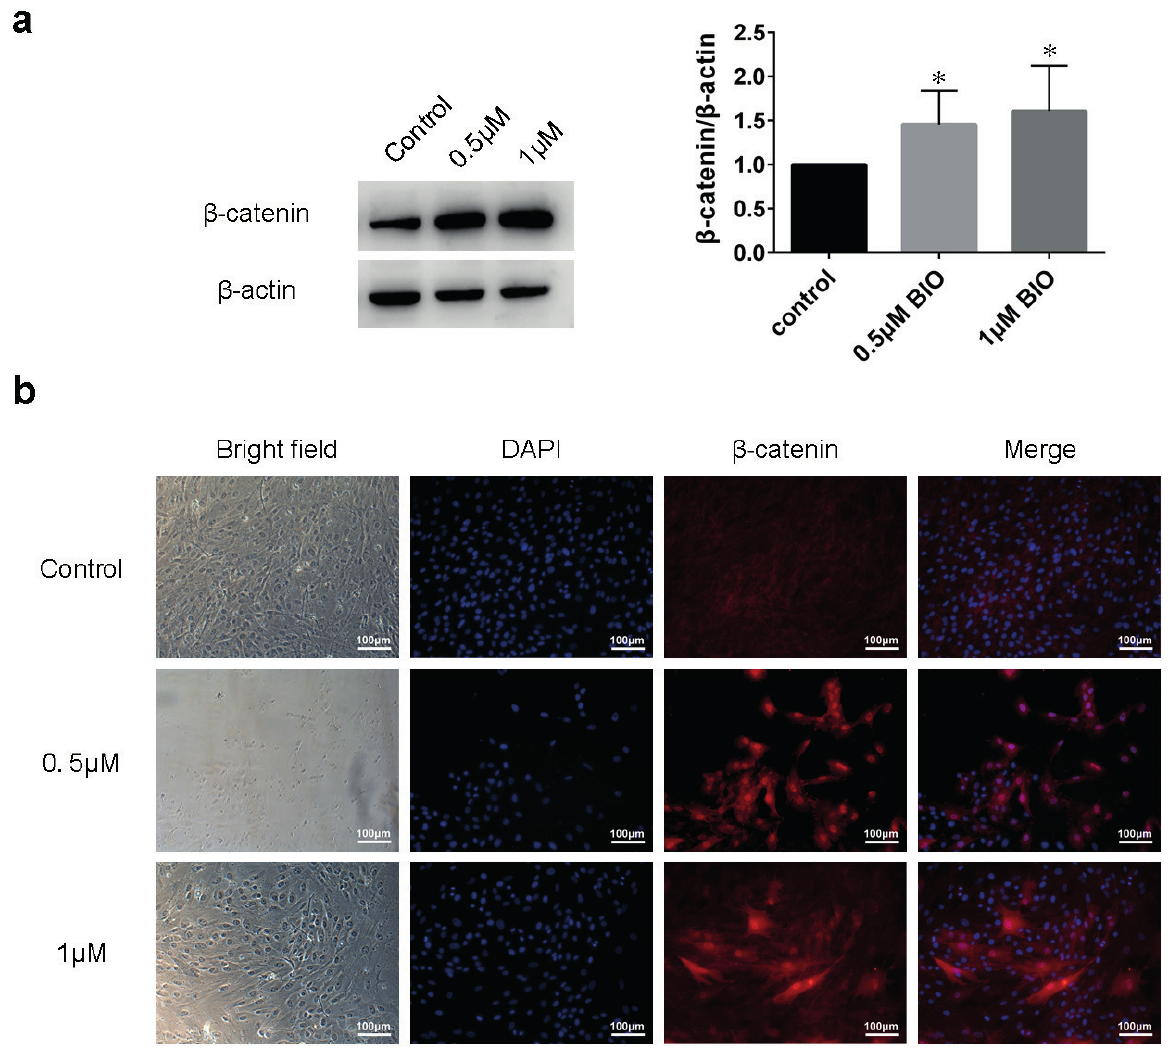
Figure 4 - BIO activated Wnt/β-catenin signalling pathways in canine BMSCs. ( a ) BIO up-regulated β-catenin expression in canine BMSCs. ( b ) BIO promoted the accumulation of β-catenin in the cell nuclei. Canine BMSCs were incubated with basic medium, osteogenic medium with or without BIO for 4 days, detected expression of β-catenin by Western blot and immunocytochemistry staining. (n = 3). Error bars denote mean ± SD. *P < 0.05. Control: osteogenic medium; 0.5 and 1.0 μM BIO: osteogenic medium containing 0.5 and 1.0 μM BIO. DAPI: DAPI staining of the nucleus. β-catenin: β-catenin immunocytochemistry staining in nucleus. Merge: the superposition of DAPI and β-catenin immunocytochemistry in canine